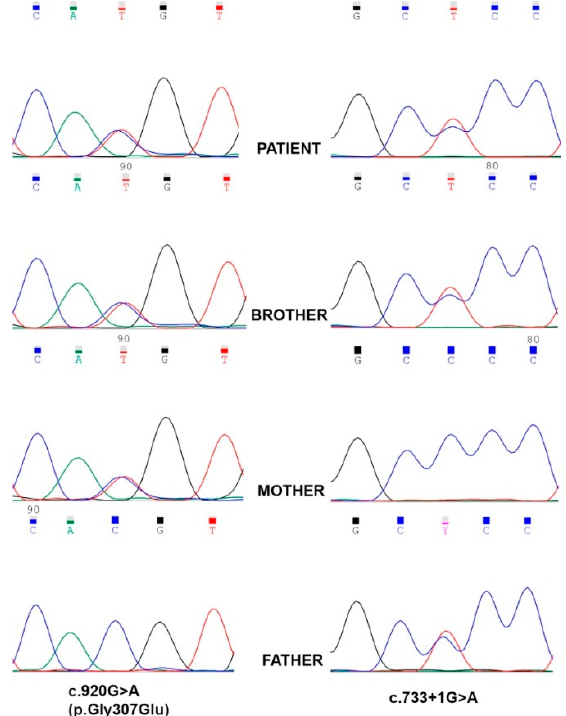
Figure 1. Reverse sequence chromatograms showing Sanger sequencing results. The missense variant c.920G>A (p.Gly307Glu), located in exon 8, was inherited from the mother and the splicing variant, c.733+1G>A, located in intron 6, was inherited from the father. The patient and affected brother harbored both variants in FOXRED1 in a compound heterozygous condition.